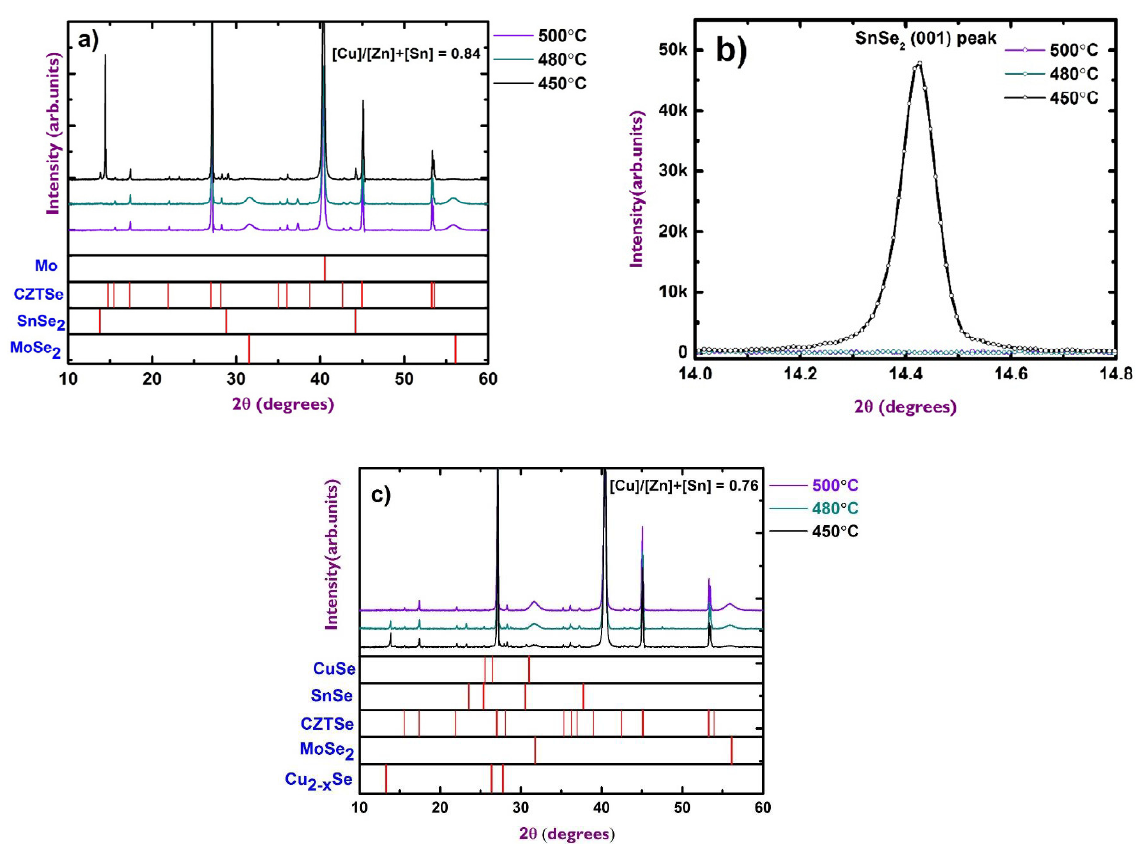
Fig. 6. (a) XRD spectrum of CZTSe thin film absorber with [Cu]/[Zn] + [Sn] ratio of 0.84 selenized at 450 ◦ C, 480 ◦ C and 500 ◦ C. (b) Section showing the disappearance of the intense (001) peak of SnSe 2 . (c) XRD spectrum of CZTSe thin film absorber with [Cu]/[Zn] + [Sn] ratio of 0.76 selenized at 450 ◦ C, 480 ◦ C and 500 ◦